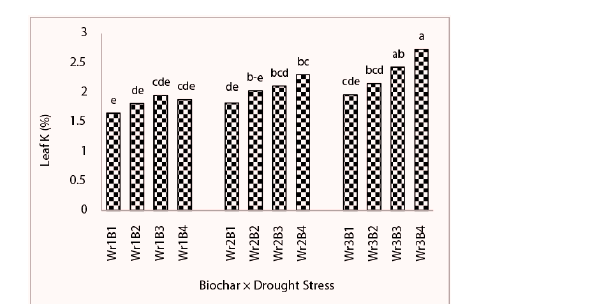
Figure 2 The effects of the interaction of drought stress and biochar on K content of melon leaf. Mean values with the same letters are not significantly different at p ≤ 0.05 according to LSD